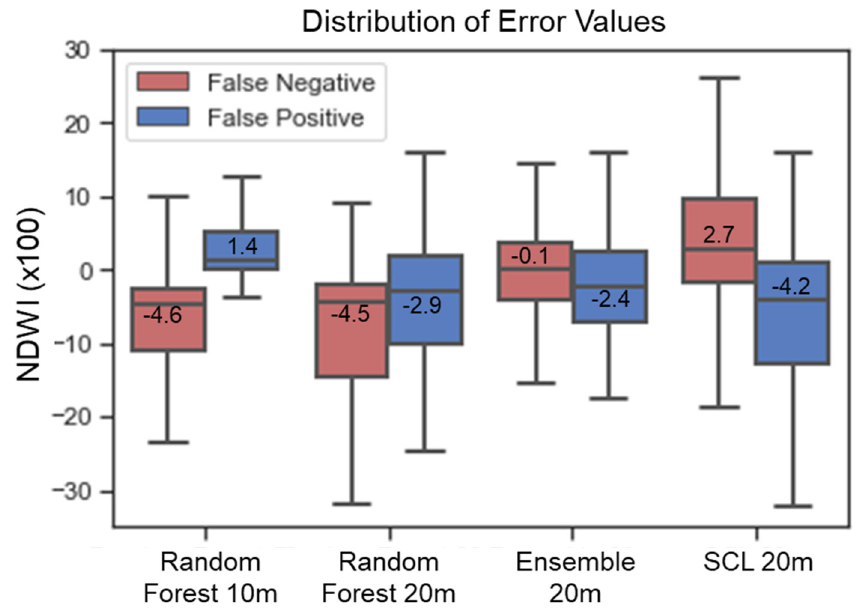
Figure 10. NDWI error patterns shown for each dataset including the index method with random forest (10 m), ensemble index method with random forest (20 m), ensemble only method (20 m), and the water mask from the scene classification layer (SCL 20 m).